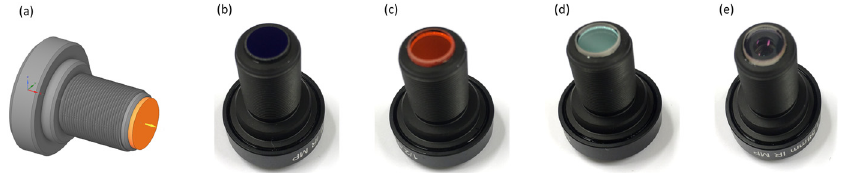
Figure 6. Cemented optical filters on the wide FOV lens: ( a ) technical drawing indicating the cementing of the filters, with the optical bandpass filter indicated in orange; ( b ) channel 1 featuring the MidOpt BP695 filter, ( c ) channel 2 featuring the MidOpt BN595 filter, ( d ) channel 3 featuring the MidOpt DB660/850 filter, ( e ) channel 4 featuring the MidOpt BP550 filter.